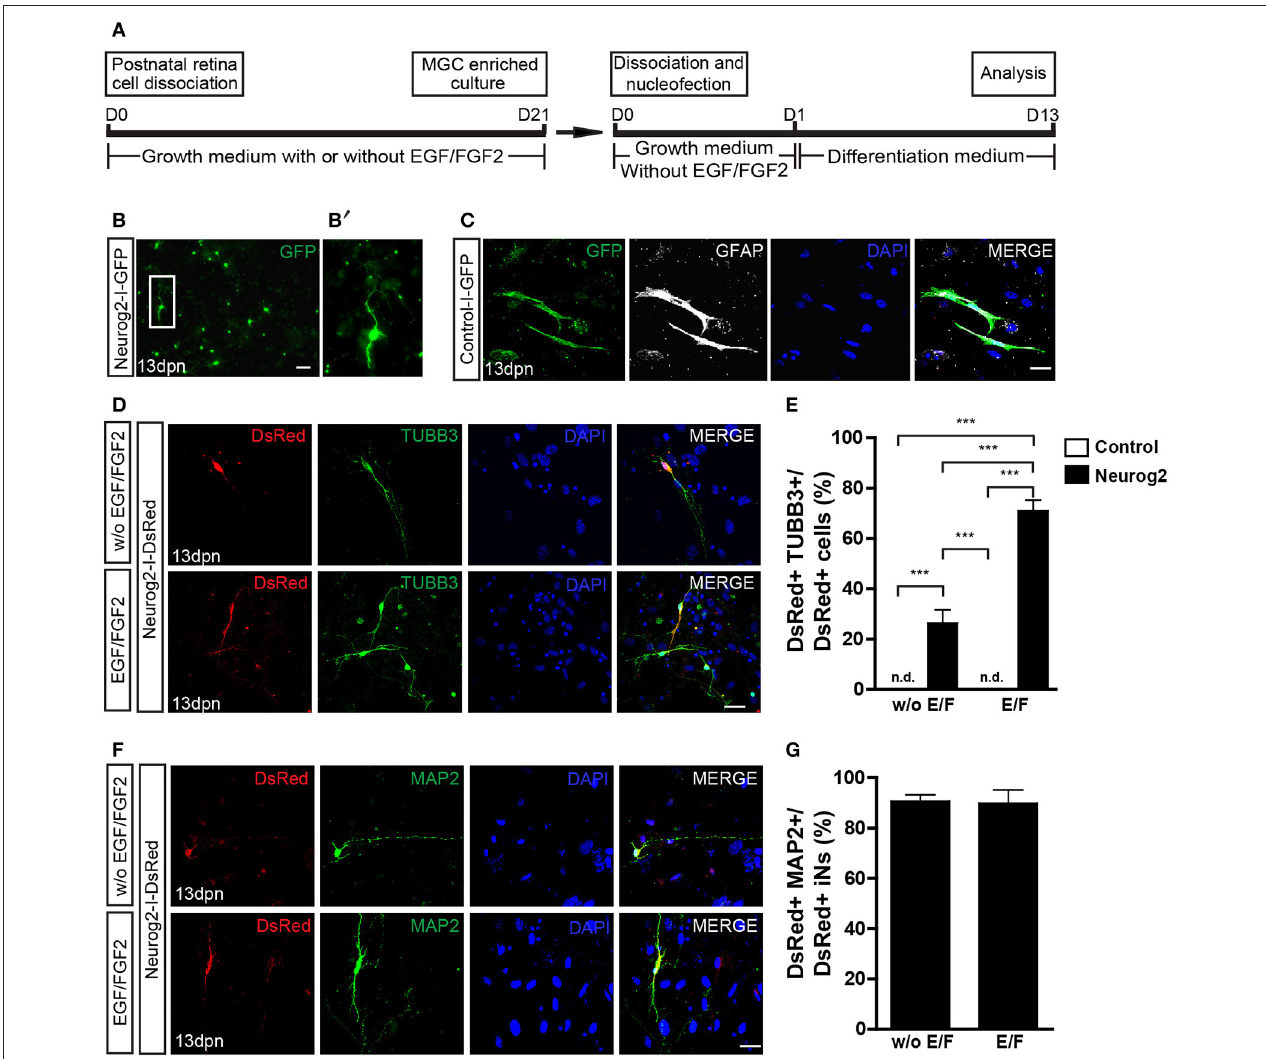
FIGURE 2 | Expression of NEUROG2 converts MGCs into iNs. (A) Experimental design. Note that EGF/FGF2 are used only during MGC expansion. (B–B’) Overview of MGC cultures 13 days post nucleofection (dpn) with Neurog2-I-GFP showing the presence of GFP + cells (green) adopting a neuronal-like morphology (white inset, magnified in B’ ). (C) Representative photomicrographs of MGC cultures at 13 dpn with control-I-GFP, showing GFP + cells (green) that maintain glial morphology and contain GFAP (white). (D) Immunolabeling of the neuronal protein β III -TUBULIN (TUBB3, green) in DsRed (red) cells at 13 dpn with Neurog2-I-DsRed in MGCs